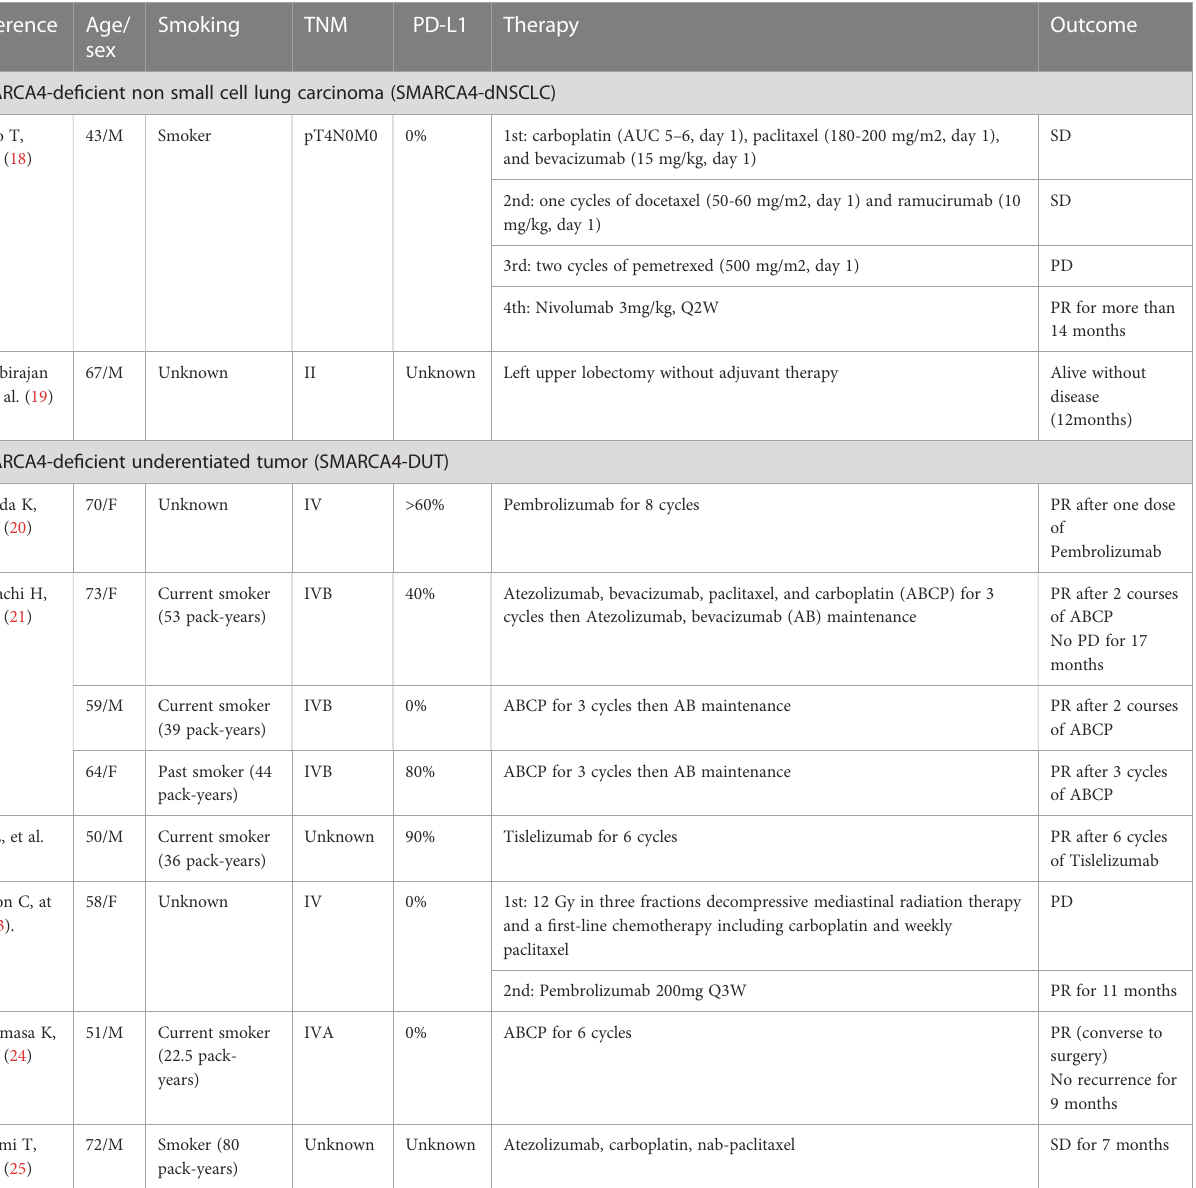
TABLE 2 Comparison the effect of various treatments on SMARCA4-dNSCLC and SMARCA-4 DUT).